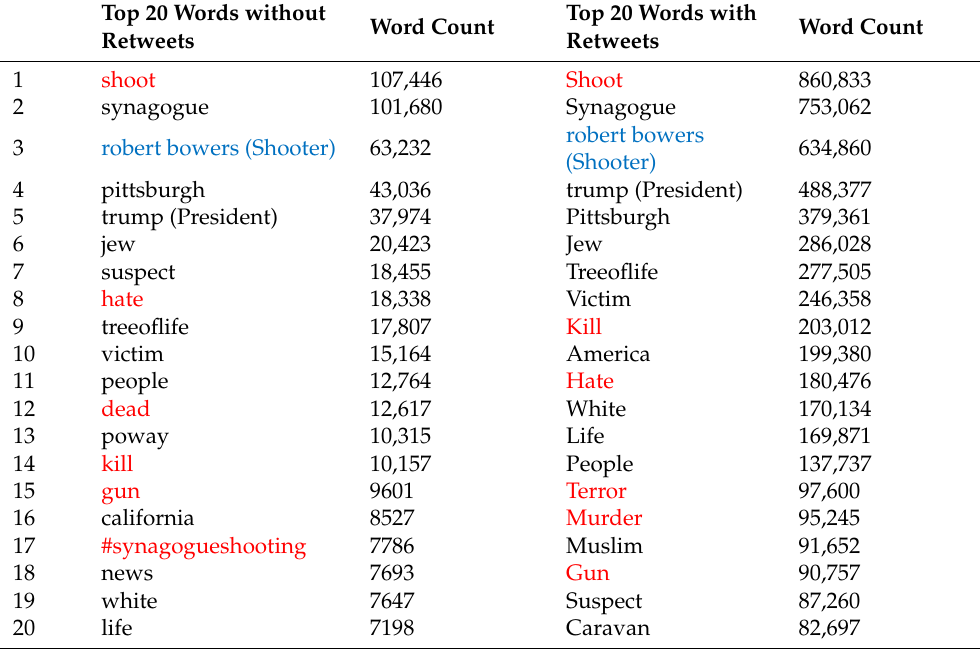
Table 6. Word frequency for the Synagogue